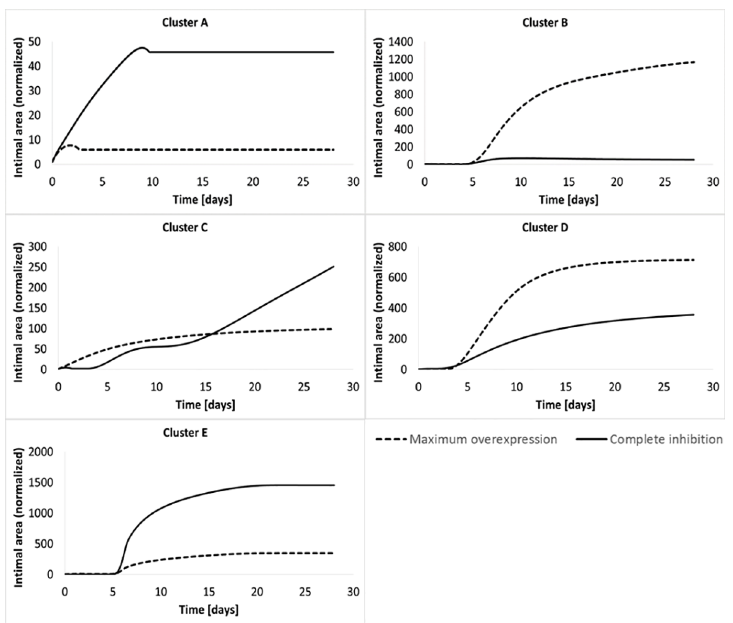
Fig 9. Gene therapy principle. Comparisonbetweenthicknesses of the wall dynamicaltered with cluster set at maximum overexpression (dashedline) and completeinhibition(solid line).